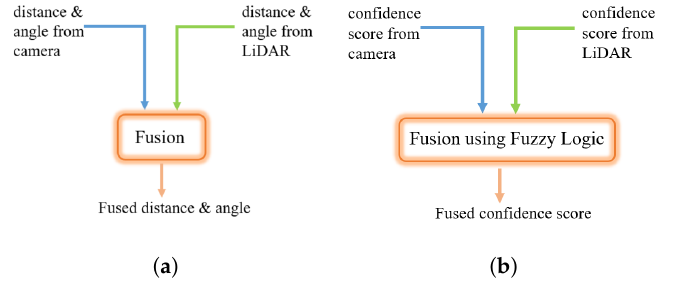
Figure 18. ( a ) Fusion of distances and angles. ( b ) Fusion of confidence scores. Fusion of distances, angles and confidence scores from the camera and LiDAR.